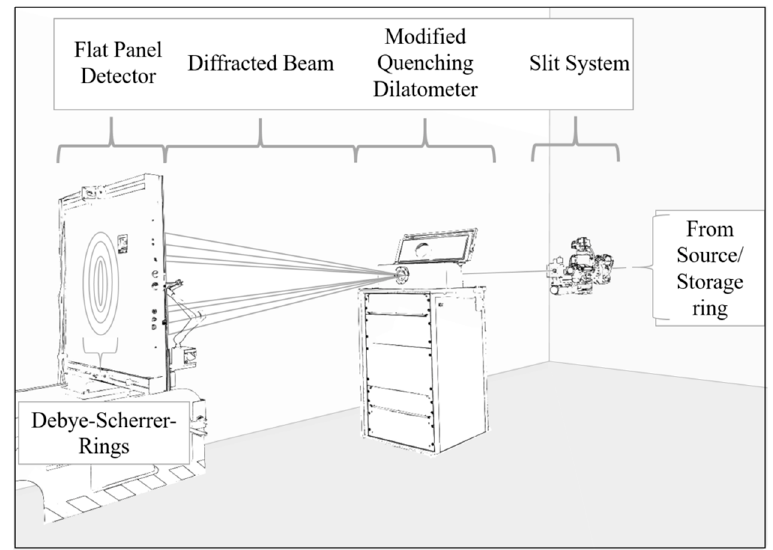
Figure 2. Schematic experimental set-up at the HEMS beamline @ DESY showing the final primary beam slit system, the modified dilatometer and the flat panel detector capturing the Debye–Scherrer rings of the diffracted beam in transmission geometry (for detailed information on the set-up with view into the dilatometer chamber with the sample position in relation to the induction coil, see [25]).